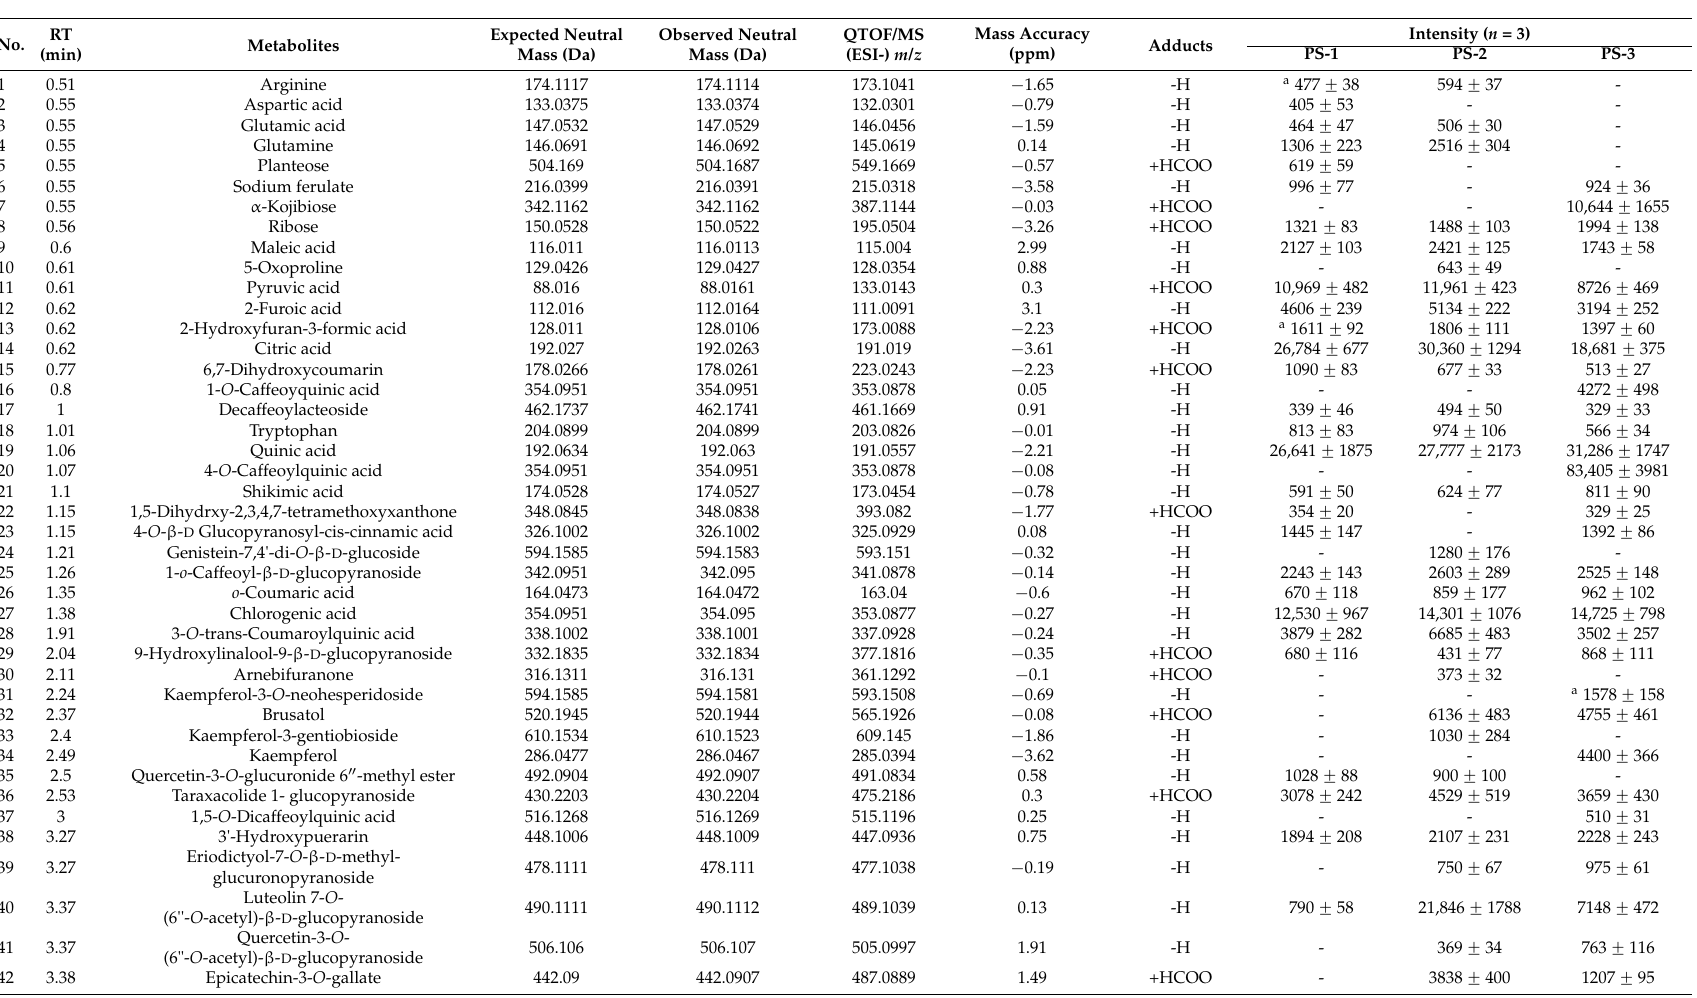
Table 4. List of metabolites analyzed in P. grandiflorum stems and leaves